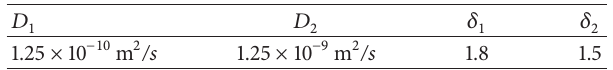
Table 3: Parameters used for the enhanced Maxwell homogeniza- tion